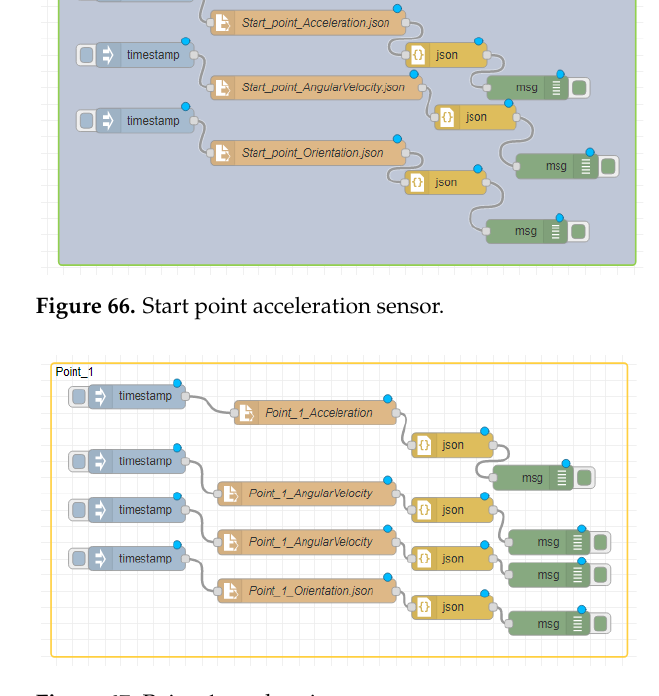
Figure 67. Point_1 acceleration sensor.